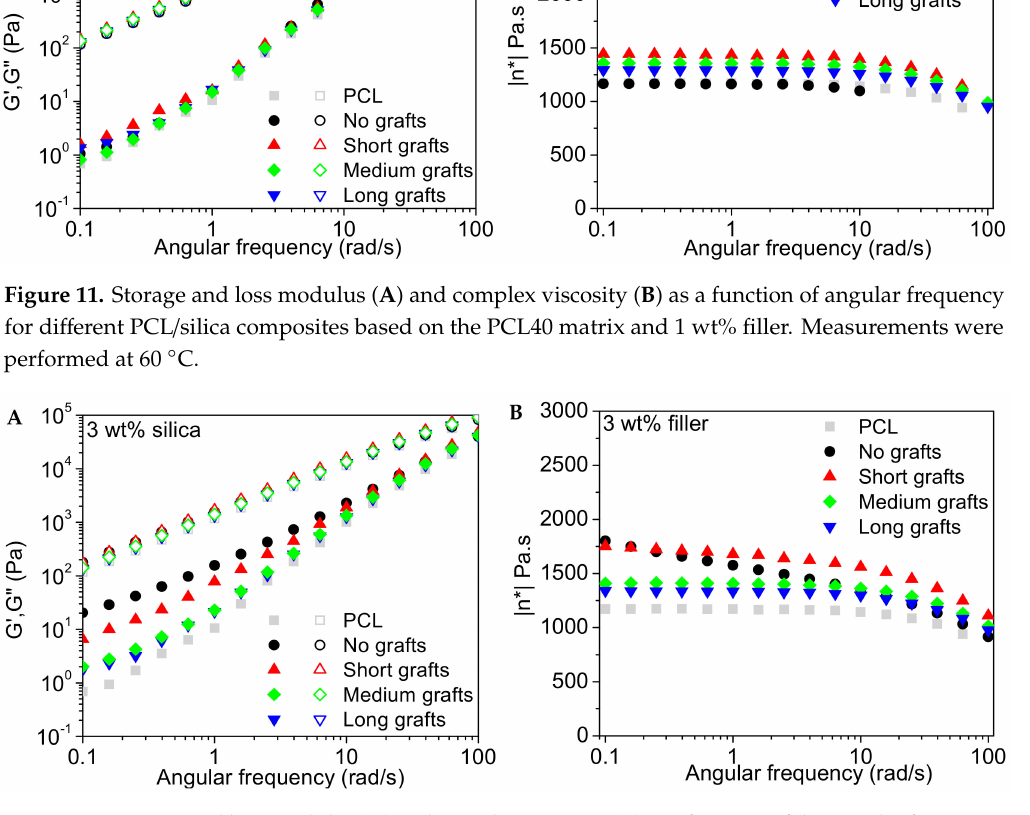
Figure 12. Storage and loss modulus ( A ) and complex viscosity ( B ) as a function of the angular frequency for di ff erent PCL / silica composites based on the PCL40 matrix and 3 wt% filler. Measurements were performed at 60 ◦ C.